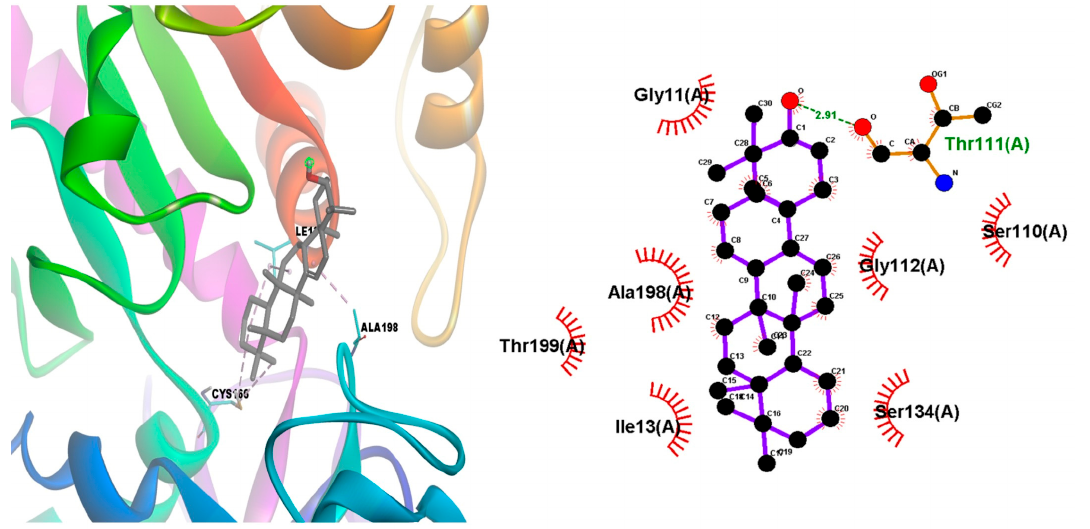
Figure 4. Episwertenol compound interaction of allosteric binding sites of target proteins GAPDH (PDB: 1A7K).